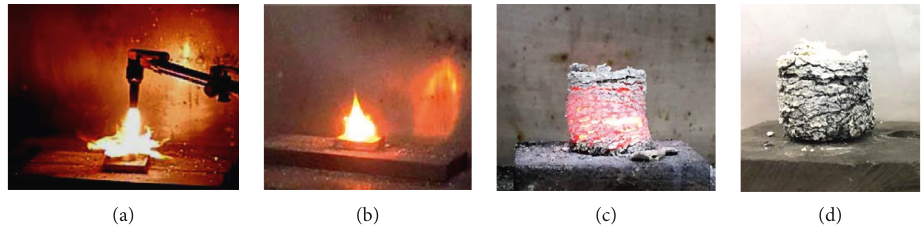
Figure 3: Snapshot images illustrating the various stages of combustion reaction within reactant compact of high-energy-milled duck eggshell+A-TiO 2 /Mg carried out in air. (a) ignition, (b) self-combustion, (c) relaxation, and (d) final product.